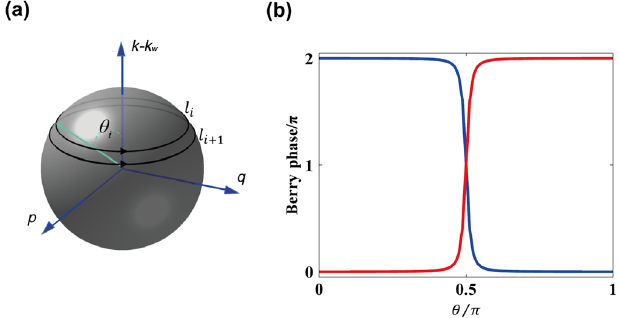
FIG. 7. The method to calculate the charge of the Weyl point numerically. (a) Schematic illustration of the integration paths used to calculate topological charges of Weyl points. (b) Berry phases defined on the spherical surface with fixed θ , where blue and red represent Berry phases on the lower band and the upper band, respectively. The parameters of the PC are given by d 97 nm, d 72 nm, and the Weyl point considered is a ¼ b ¼ between the first and the second band. The radius of the sphere is